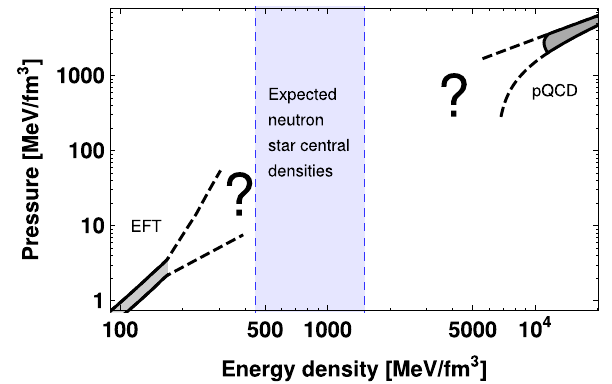
Fig. 2 PredictionsfortheQCDEOSfromsystematictheoreticalmeth- ods at low [49,83] and high [62] densities compared to the estimated range of central densities in neutron stars